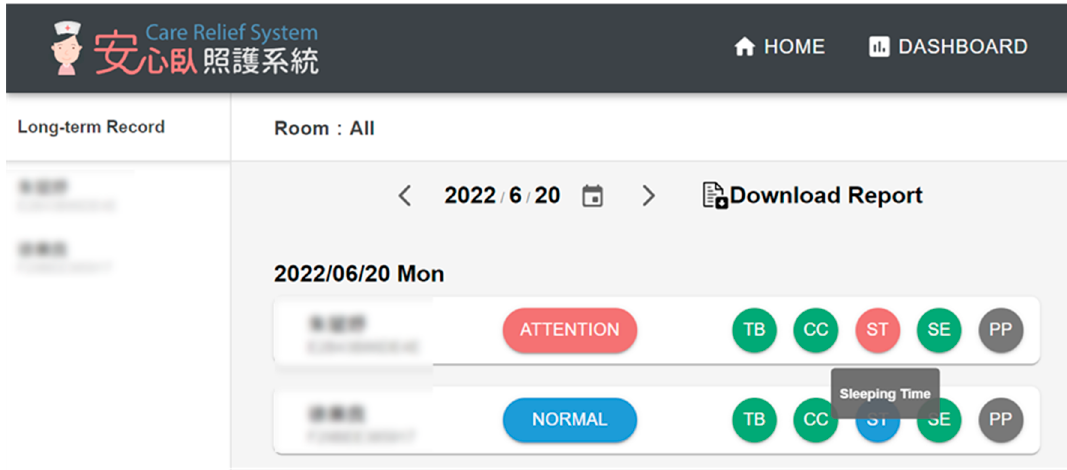
Figure 12. The list of records of all residents.